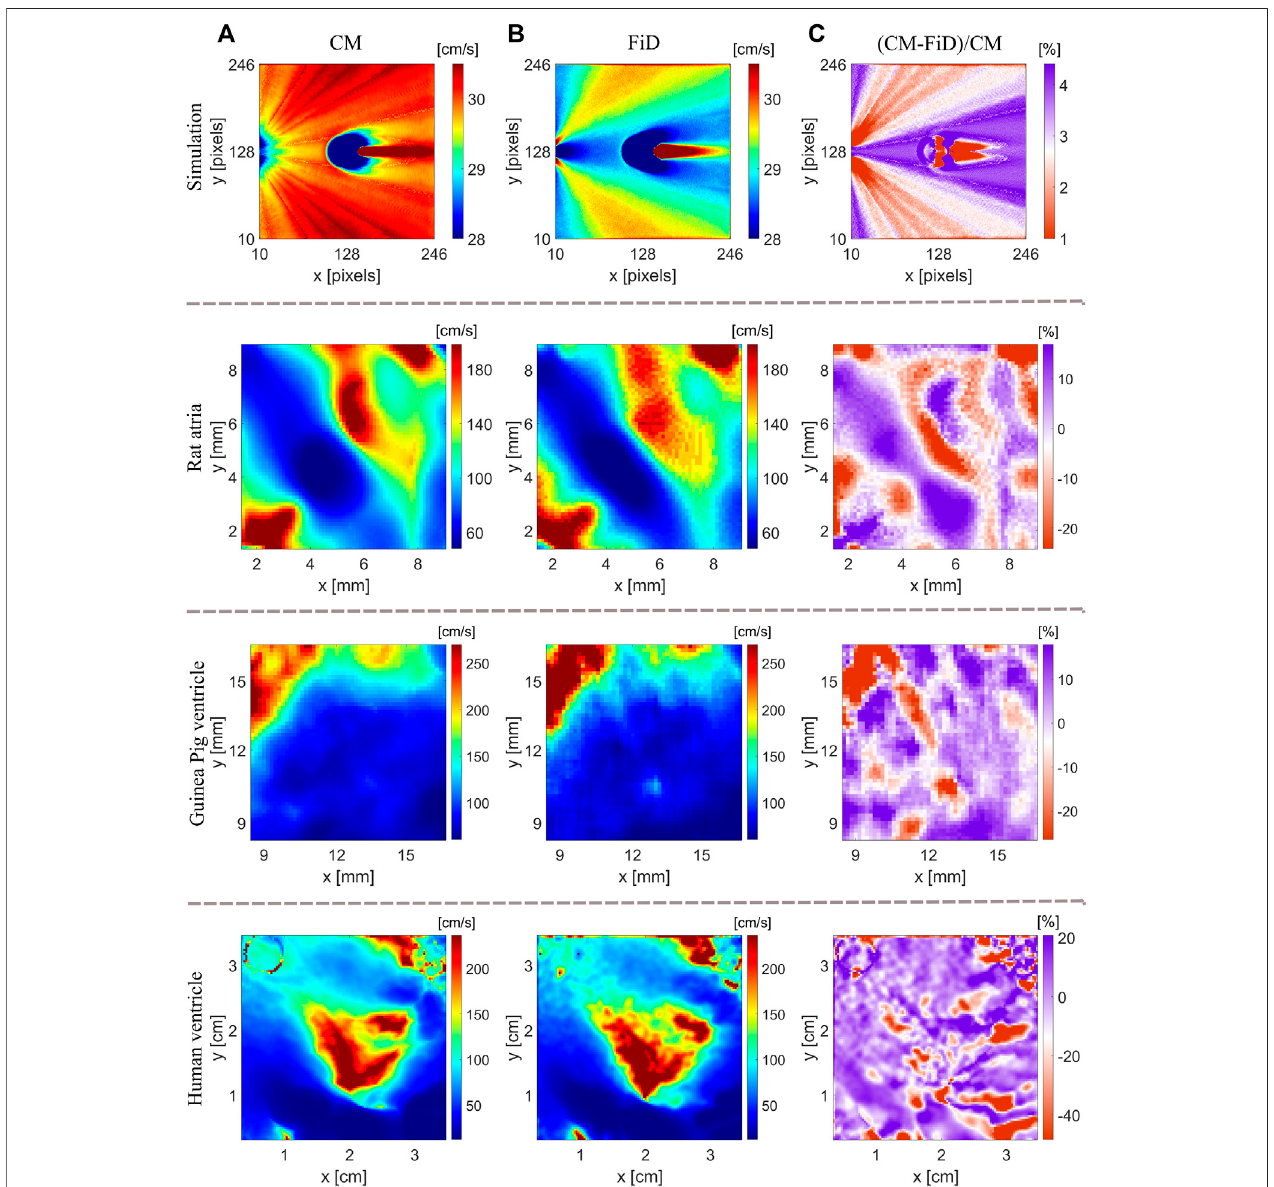
FIGURE 8 | Comparison of CV maps using the CM and FiD method. (A) CV maps generated with the CM method for the simulation, rat ’ s atria, guinea pig ’ s ventricle, and human ventricle (epicardium). (B) Respective CV maps obtained with the FiD method. (C) Relative difference of CV maps obtained with the two methods.